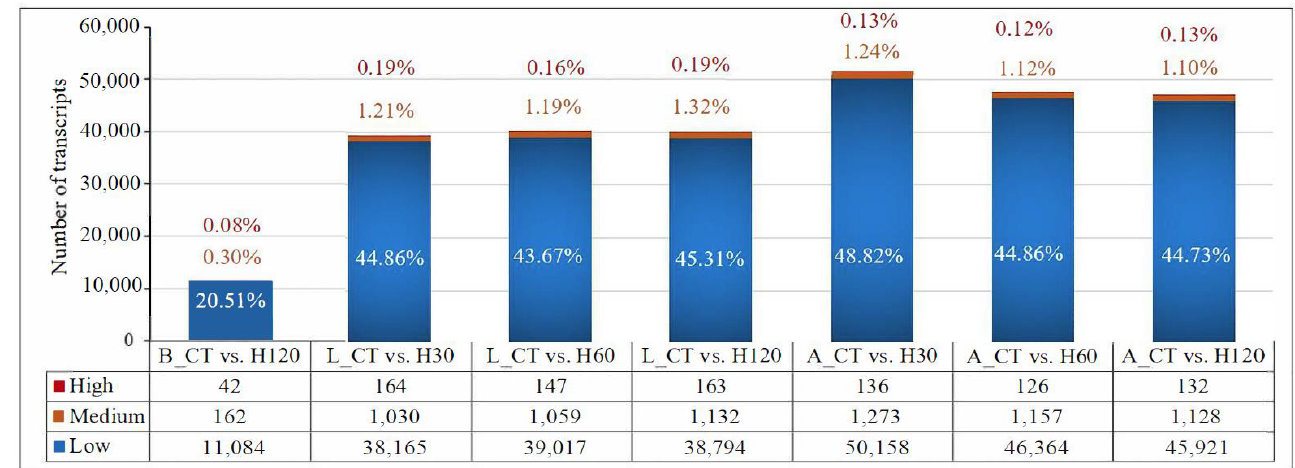
Figure 1. Statistics of the number of transcripts identified in blood, liver, and adrenal glands under various heat stress conditions. High, medium, and low mean the high, moderate, and low expressed transcripts. The statistic numbers marked in white, orange, and red means the ratio of transcripts with different expression levels to all transcripts identi- fied in blood, liver, and adrenal glands under various heat stress conditions. B, L, and A mean blood, liver, and adrenal gland tissues, respectively. CT means rats housed at 22 ± 1 °C and relative 50% humidity; the H30, H60, and, H120 mean the rats exposed to 42 °C for 30 min, 60 min, and 120 min with a relative humidity of 50%.